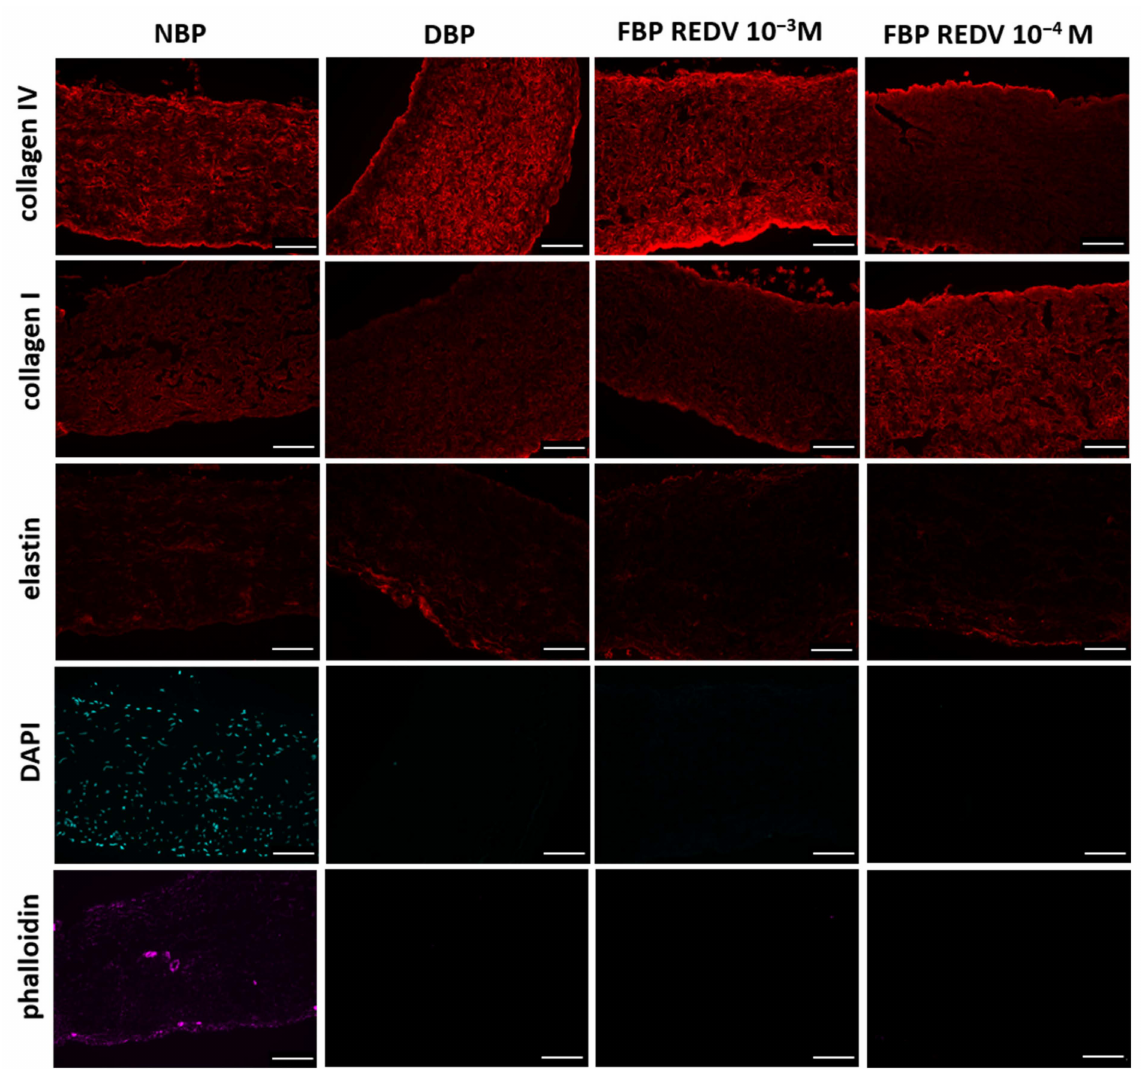
Figure 6. Immunofluorescence staining rows report the specific staining, while columns show the specific tissue analyzed (scale bar = 100 µ